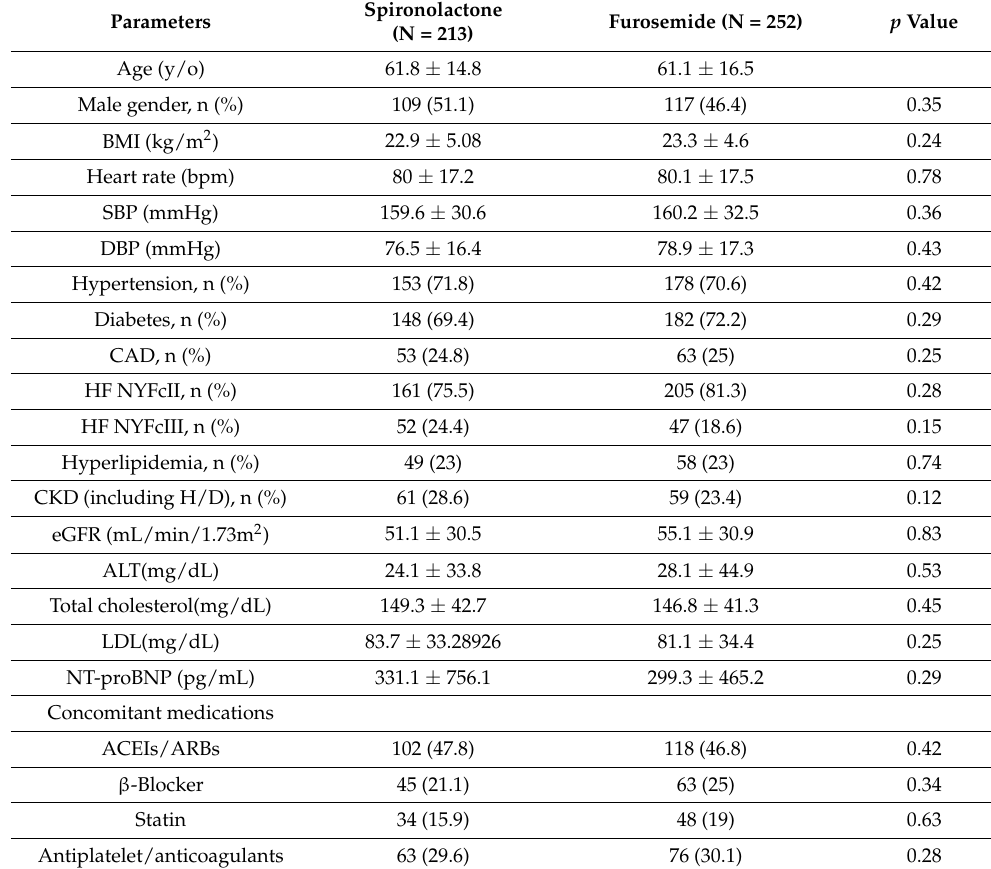
Table 1. The baseline characteristics of patients with moderate/severe mitral regurgitation receiving either spironolactone or furosemide (N =